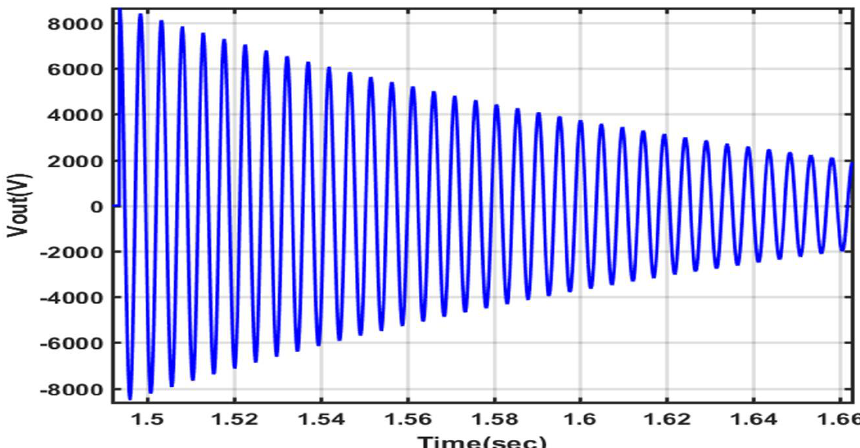
Figure 7. Dynamic response of the buck converter with CPL in an open loop mode.